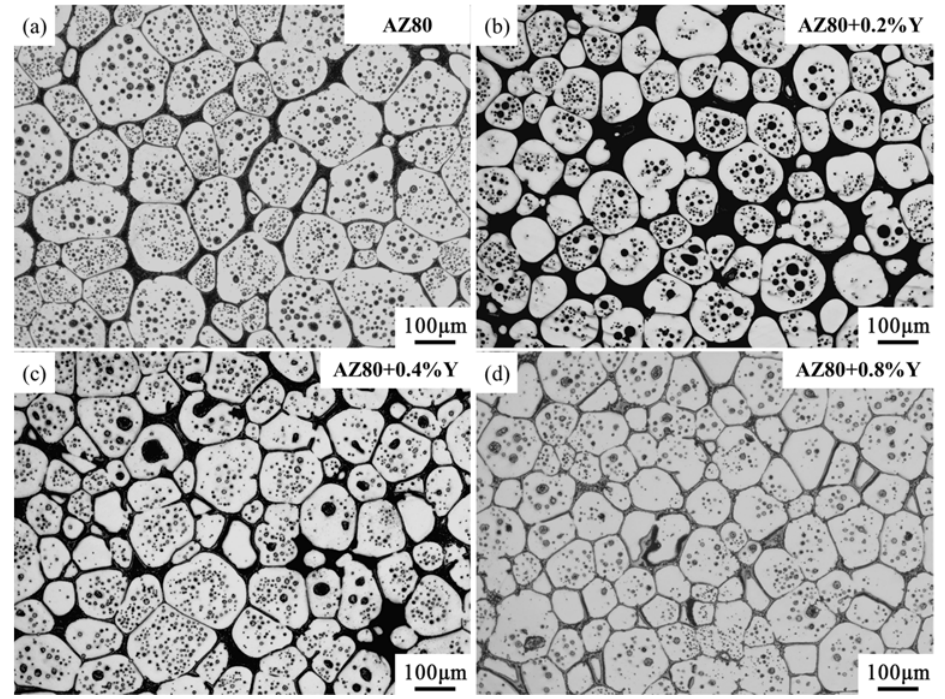
Figure 7. Microstructure evolution of alloys isothermally treated at 570 °C holding for 30 min: ( a ) AZ80; ( b ) AZ80M1; ( c ) AZ80M2; and ( d ) AZ80M3.